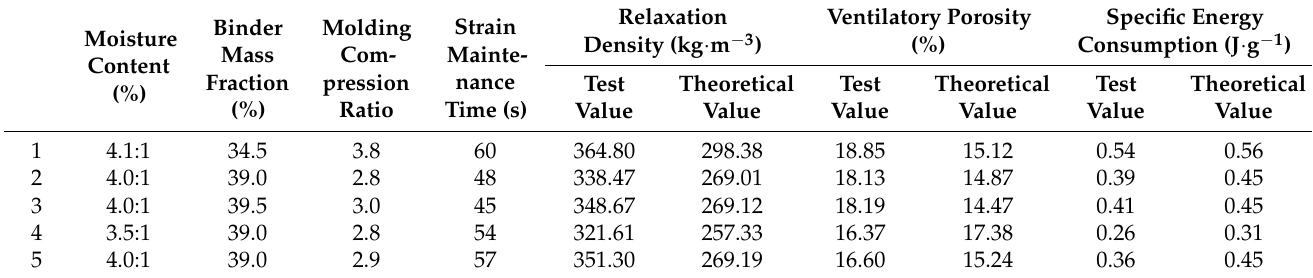
Table 5. Prediction and test results of rabbit manure compost seedling nursery blocks after parameter